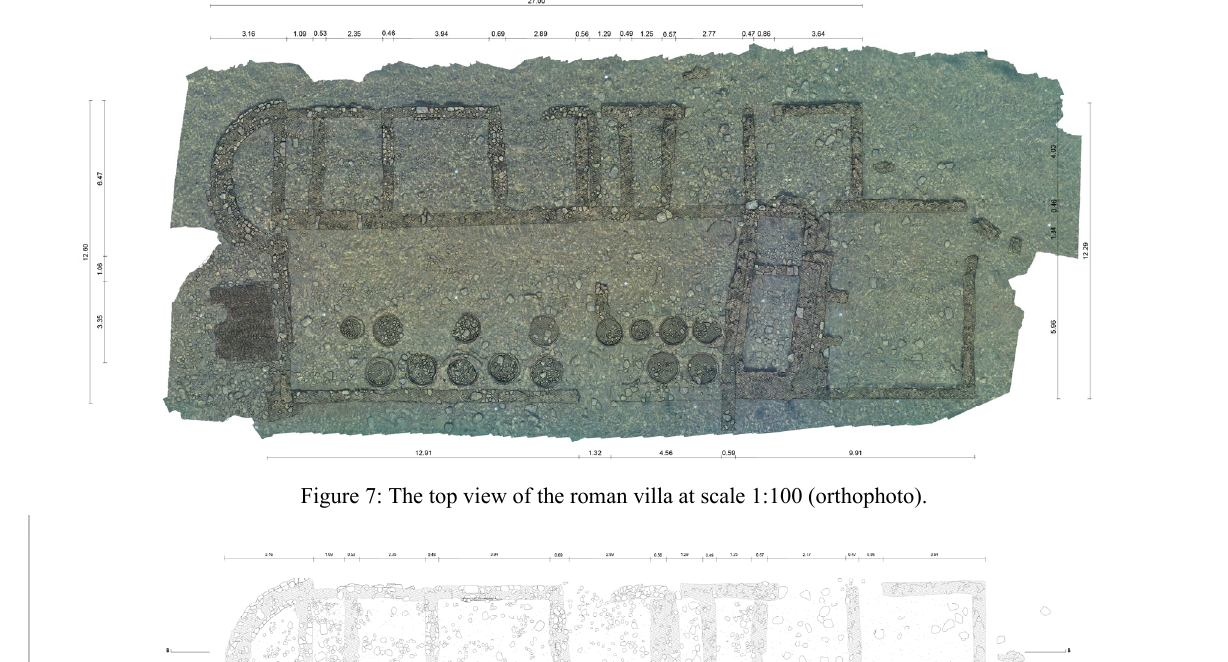
Figure 7: The top view of the roman villa at scale 1:100 (orthophoto).